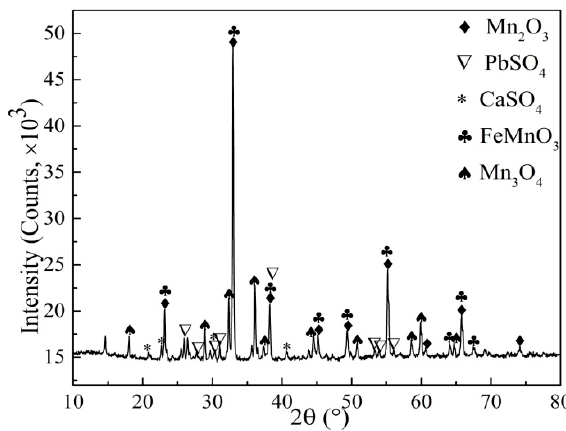
Figure 6. XRD of 1123 K roasted electrolytic manganese anode mud.